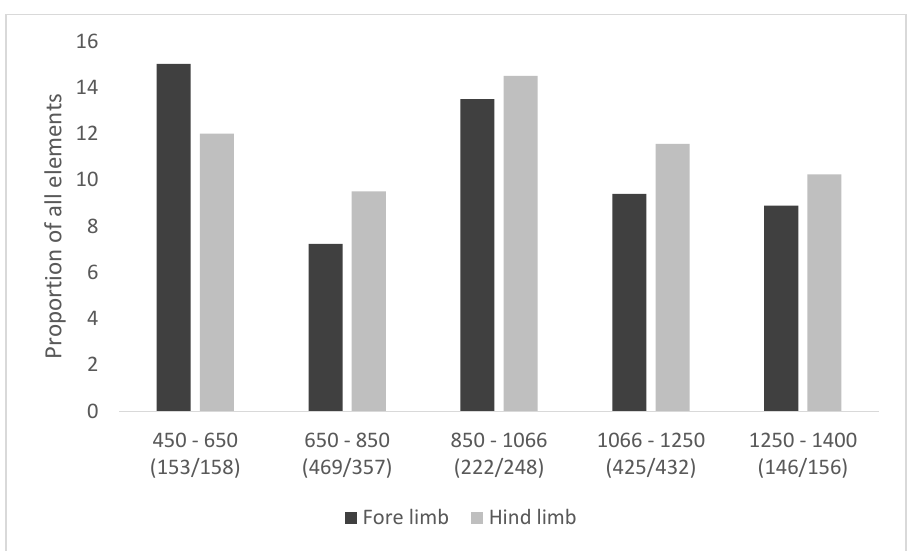
Figure 5. Cattle foot pathology data showing prevalence (proportion of all elements affected) through time. Data from targeted sites. ( n / n ) = number of elements from the fore and hind limbs.